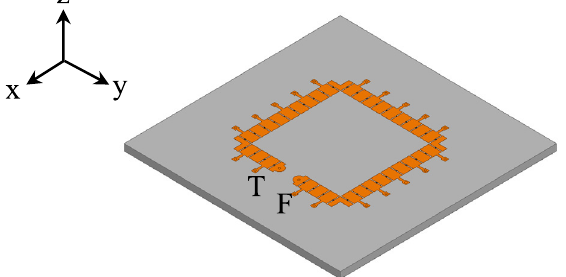
Fig. 24. Square metaloop-N antenna or SQR-MTLP-N, where N